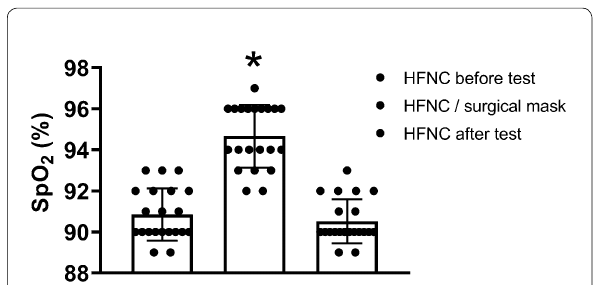
Fig. 2 Repeated SpO 2 performed with high flow nasal cannula before the test alone (HFNC before test), in presence of the surgical mask (HFNC/surgical mask) and finally again with high flow nasal cannula alone (HFNC after test). * p < 0.05 in a within‑factor ANOVA with Bonferroni correction for multiple comparisons. HNCF before compared to HFNC after the test showed no statistical difference in paired t